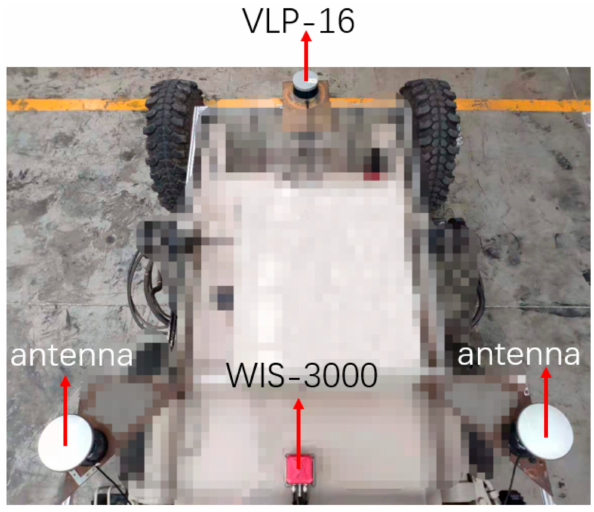
Figure 6. Experimental